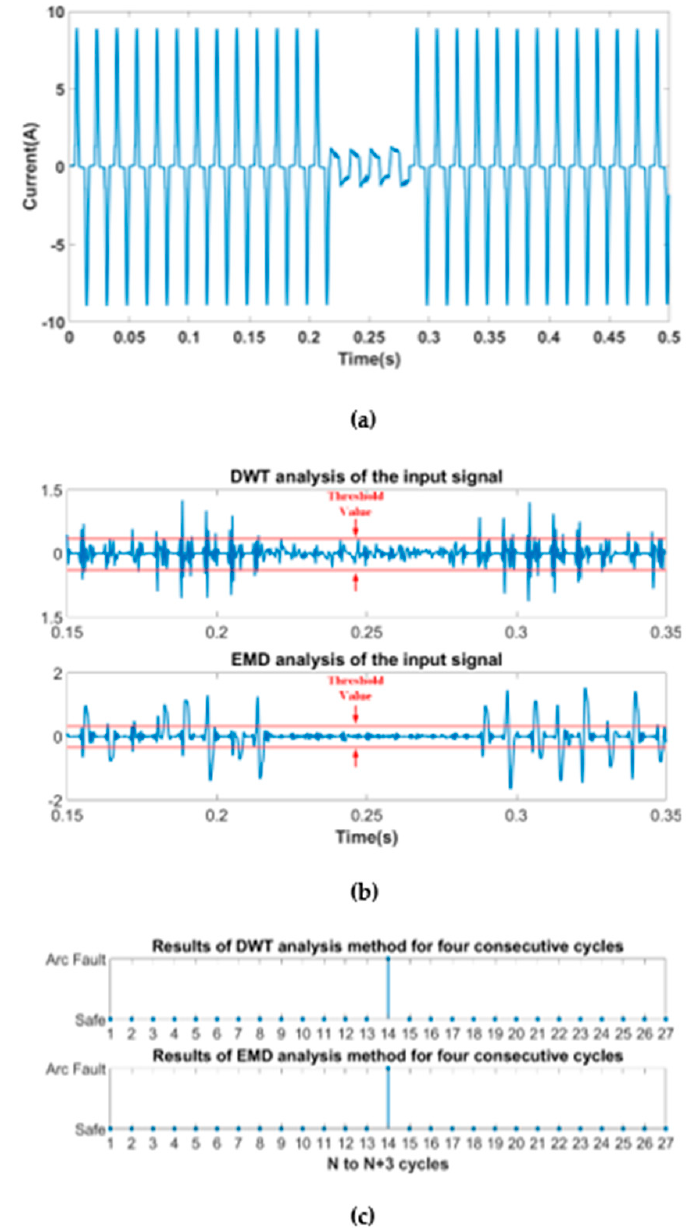
Figure 15. Series arc fault detection results of the fluorescent lamps ( a ) input current signal, ( b ) DWT and EMD analysis signal, and ( c ) the detection result of each method.